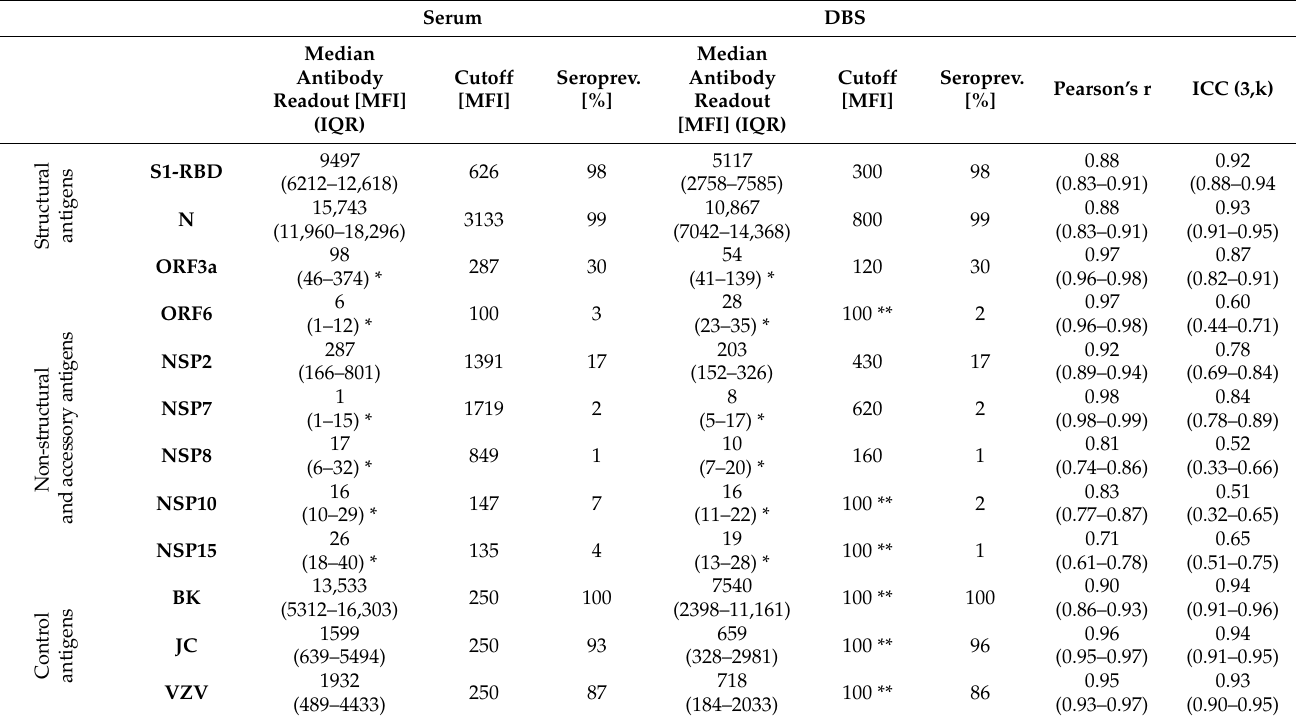
Table 1. Antibody levels of nine SARS-CoV-2 antigens and three control antigens, as measured in 142 paired DBS and serum